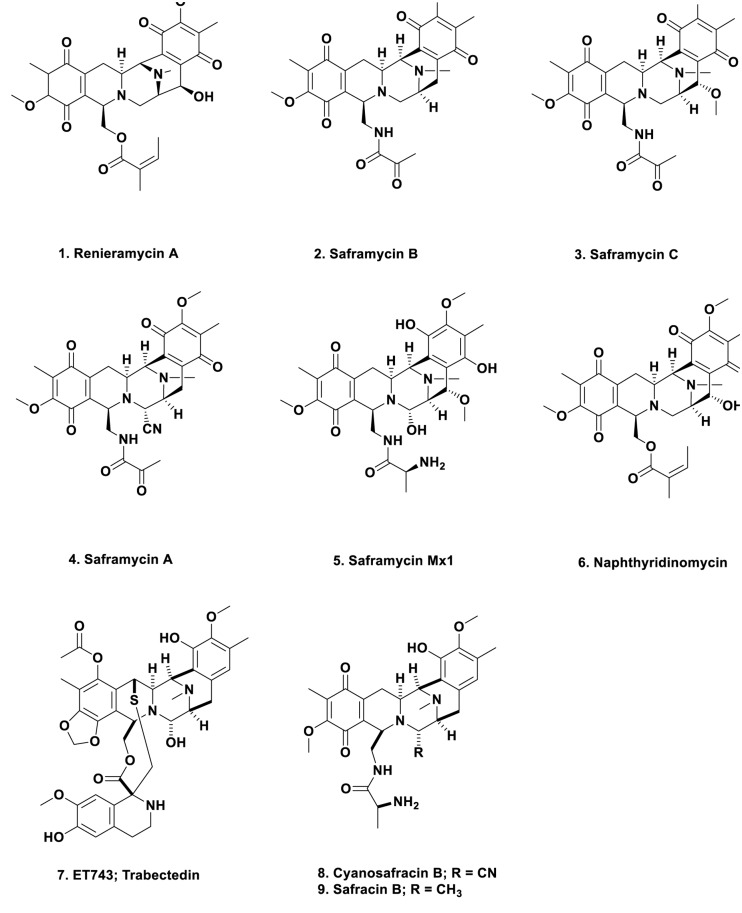
Compounds 1 to 9.